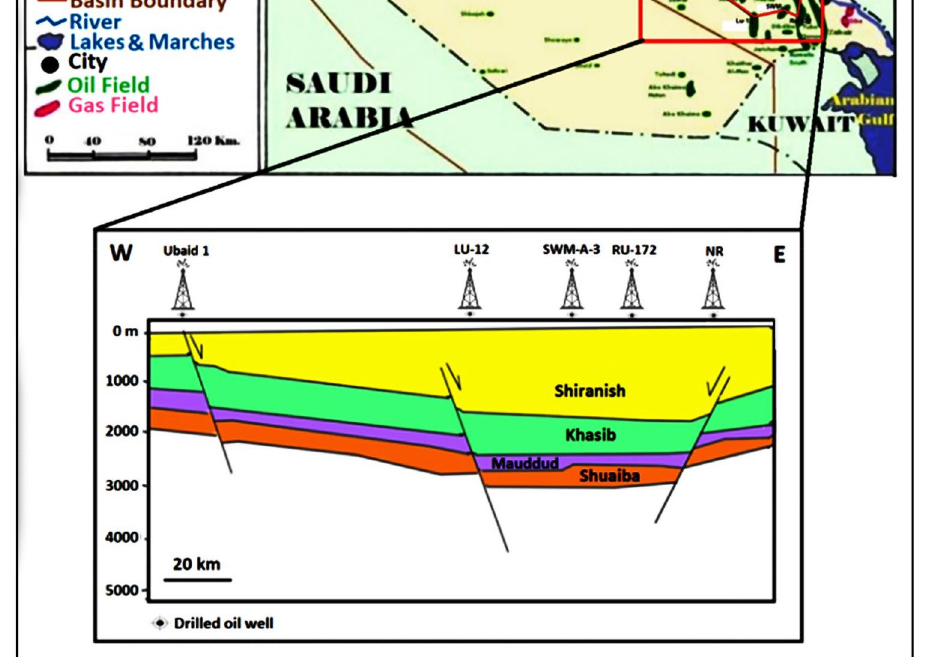
Fig. 3 A Schematic sketch showing the main structural elements crossing through the SWM Oil Field at SWM-A-3 well, the Mesopotamian Basin, Iraq